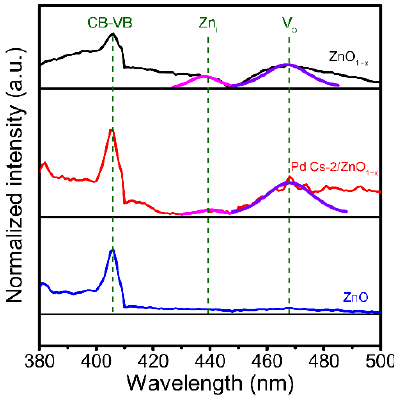
Figure 9. Photoluminescence spectroscopy of different products (ZnO, ZnO 1−x and Pd Cs-2/ZnO 1−x , respectively).